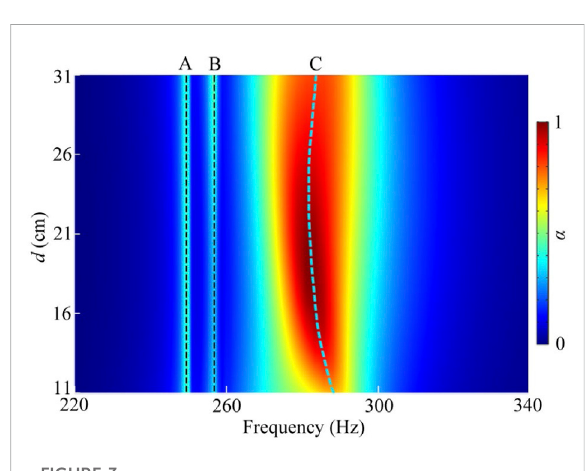
FIGURE 3 Simulated sound absorption spectra through the tunnel with different values of d . Dashed lines represent three absorption peaks A, B and